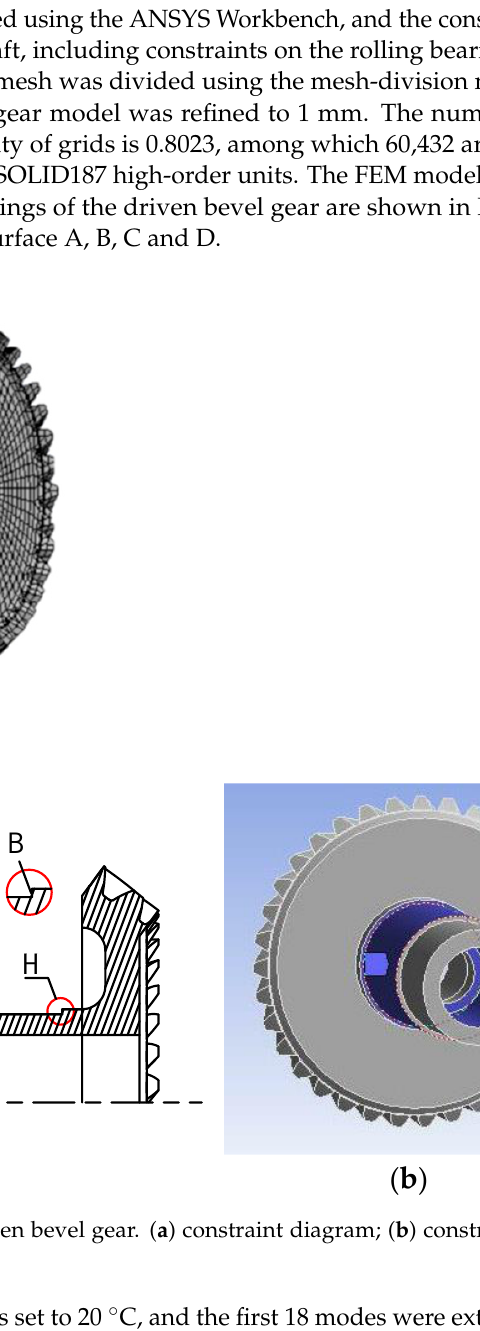
Table 3. Static frequency of vibration mode.